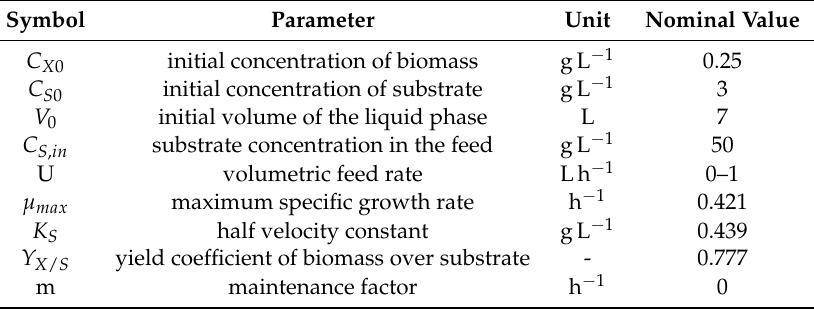
Table 6. Parameters as in [66] and initial conditions for the fed–batch